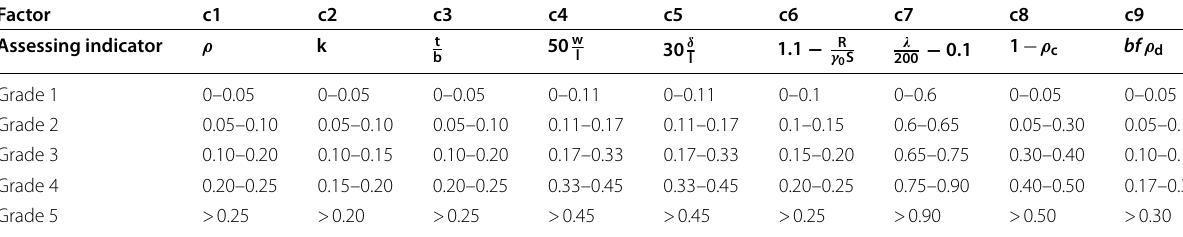
Table 2 Assessing indicators and grading criteria for compression-bending components Factor